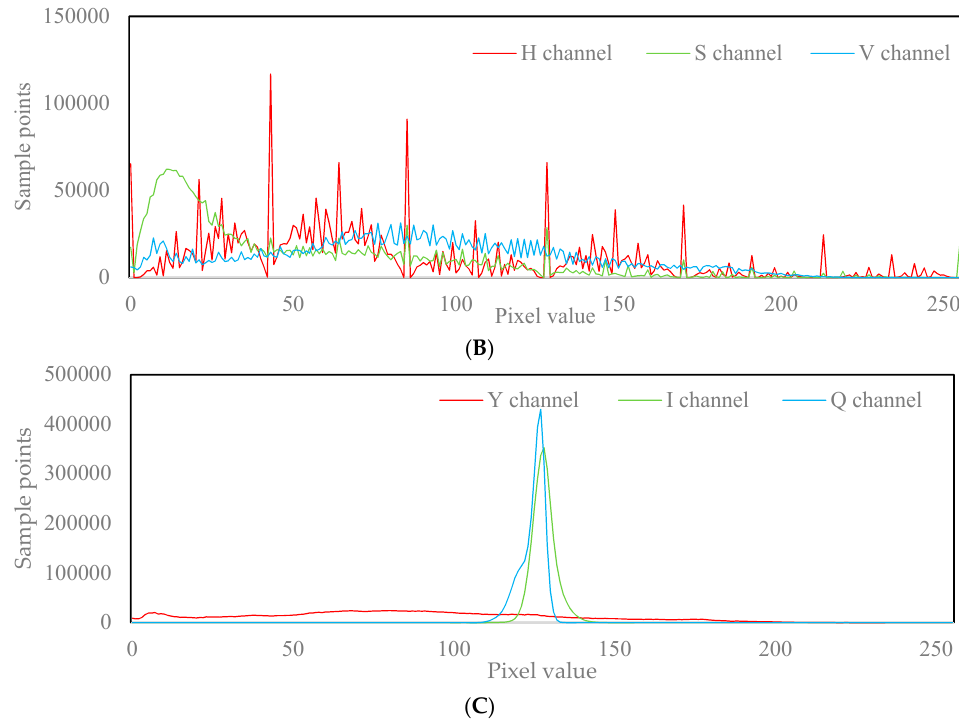
Figure 3. Gray histogram of the cabbage seedling image. ( A ) RGB color space gray histogram; ( B ) HSV color space gray histogram; ( C ) YIQ color space gray histogram. The excess green color space (see Equation (1)) is commonly used in green target segmentation. The color component of the seedling area in the sample image was significantly higher than other areas (see Figures 4 and 5), and the threshold segmentation method could realize the segmentation of seedling regions. Therefore, the excess green color space was used to segment the seedling area. where R , G , and B are the pixel values in the RGB color space. ExG is the pixel value in the excess green color space.